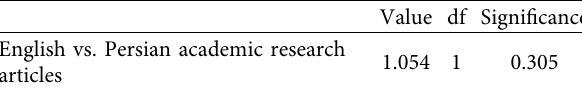
Table 3: Chi-square test for engagement resources across English and Persian academic research articles.